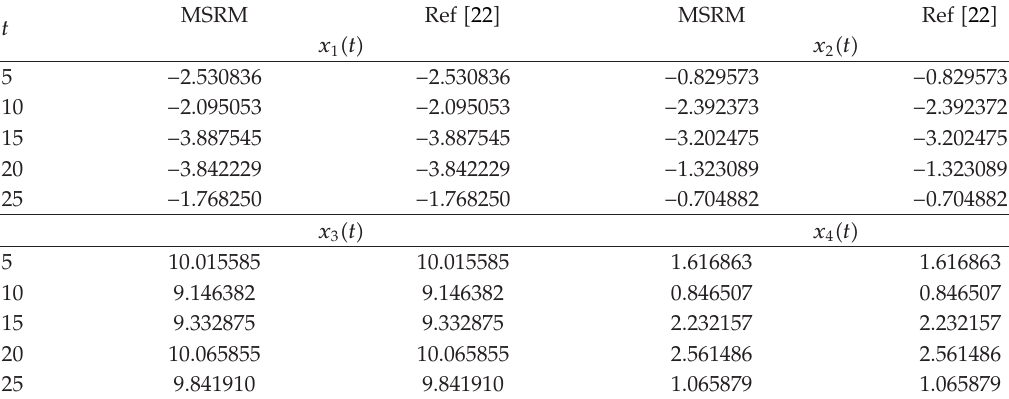
Table 2: Comparison of the numerical solution of the hyperchaotic Chen system obtained by the MSRM and ode45 with d (cid:9) 34.